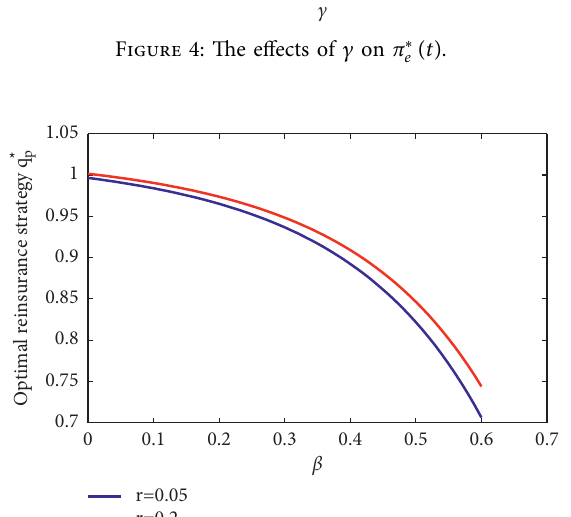
Figure 5: The effects of β on q ∗